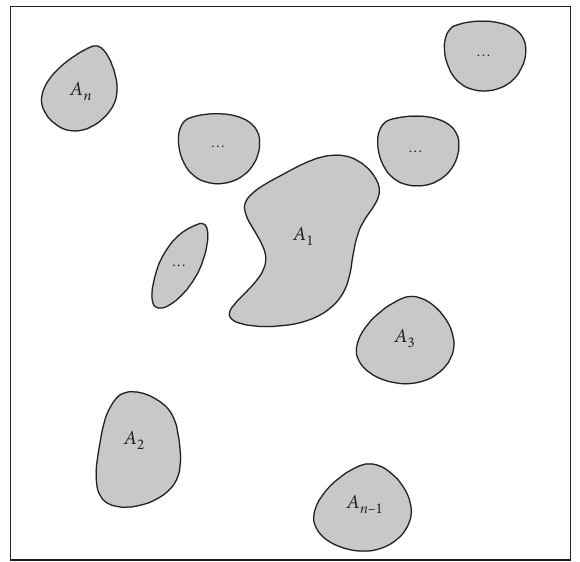
Figure 3: Schematic diagram of change of wear zone on the